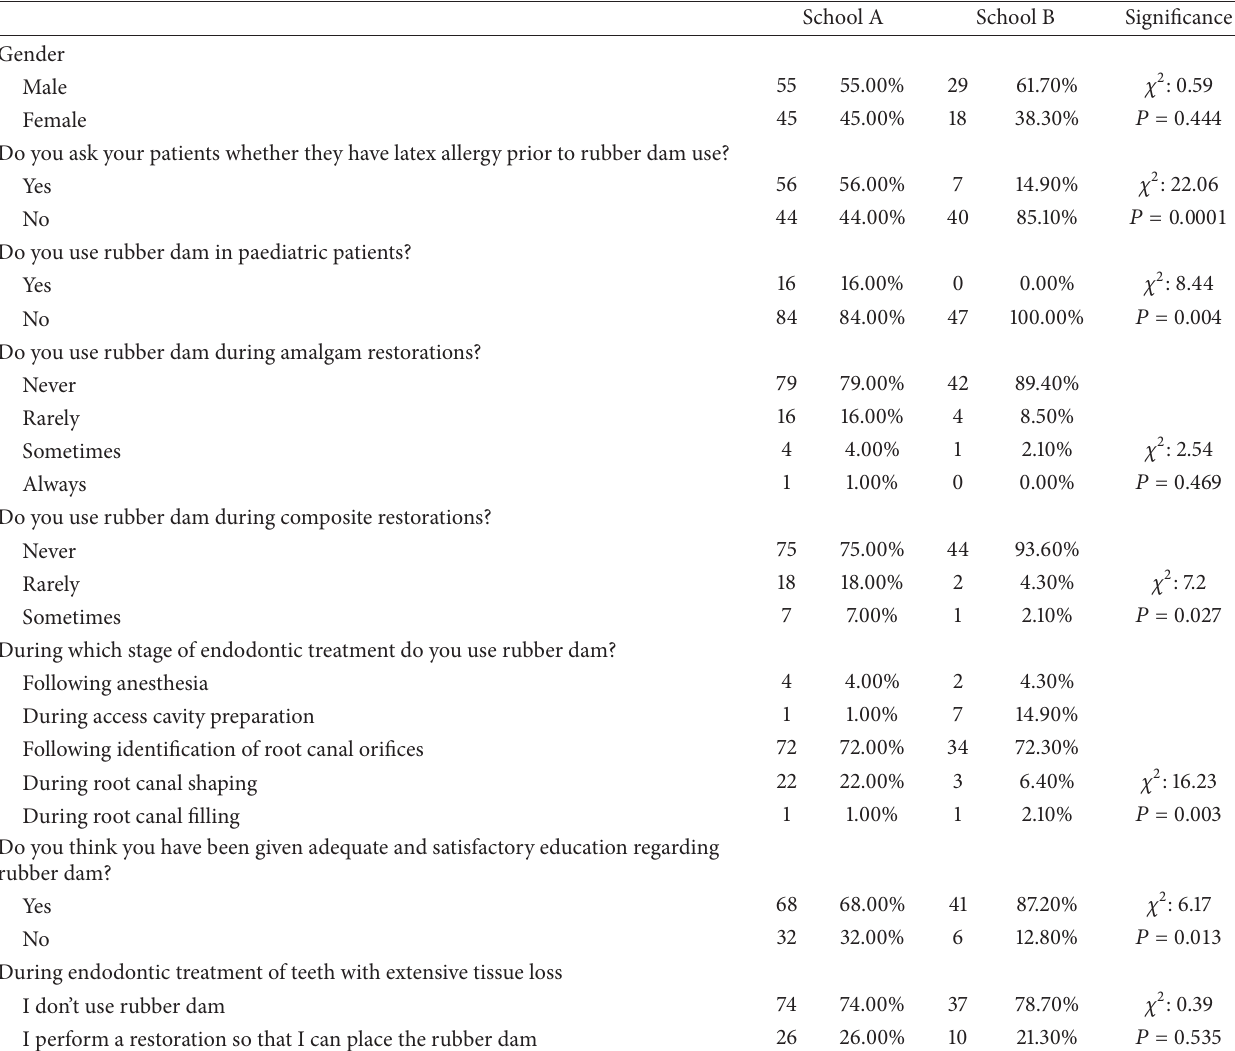
Table 1: Answers given by students to questions regarding utilization of rubber dam.